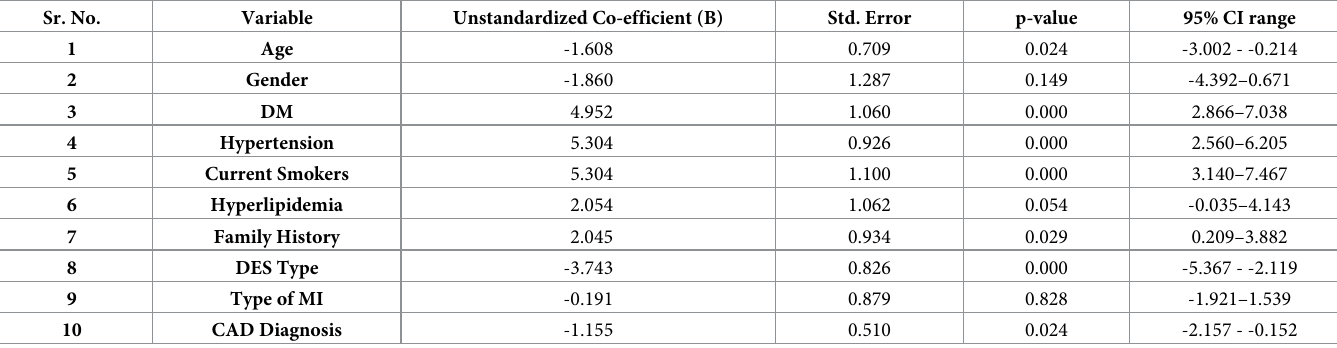
Table 5. Association of EQ-VAS values with independent